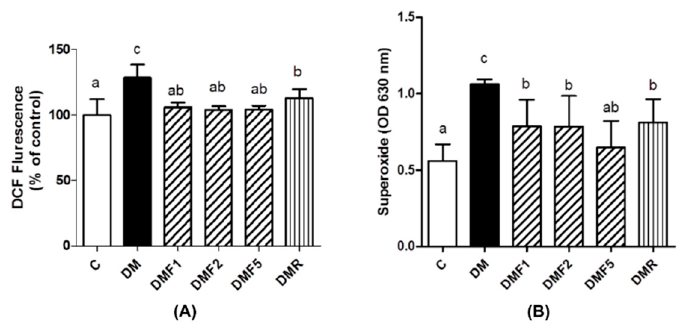
Figure 3. Effects of fucoxanthin on ( A ) reactive oxygen species (ROS) and ( B ) superoxide productions in rat sperm after treatment for four weeks. Data are shown as the mean ± S.D. ( n = 5). The values with different letters (a–c) represent significant differences ( p < 0.05) as analyzed by Duncan’s multiple range test. C, control; DM, diabetes; DMF, diabetes treated with fucoxanthin; DMR, diabetes treated with rosiglitazone.